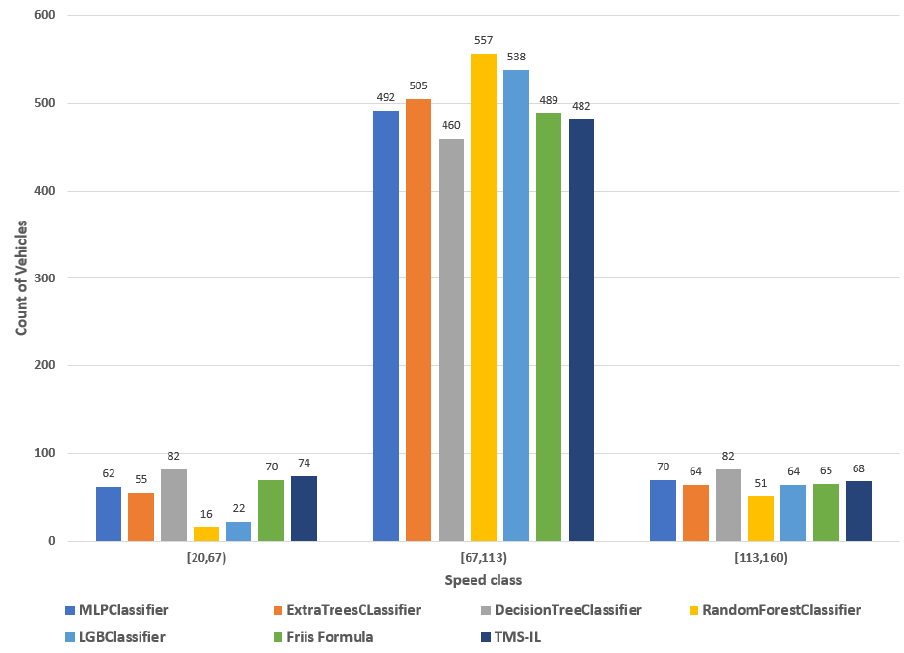
Figure 5. The 3-classes vehicle count per class over TMS-IL count per